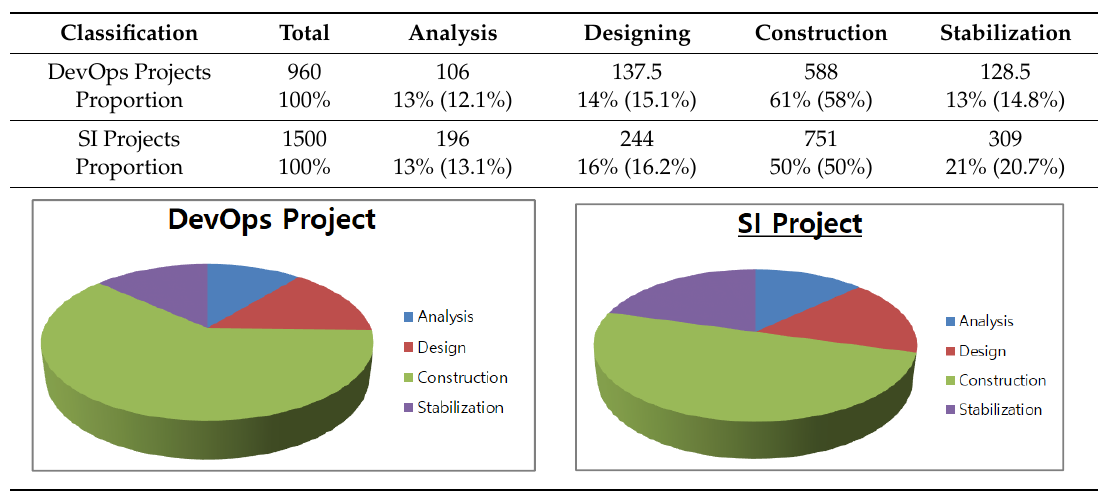
Figure 14. Workforce input by project. Table 7. Workforce input per life cycle by project.